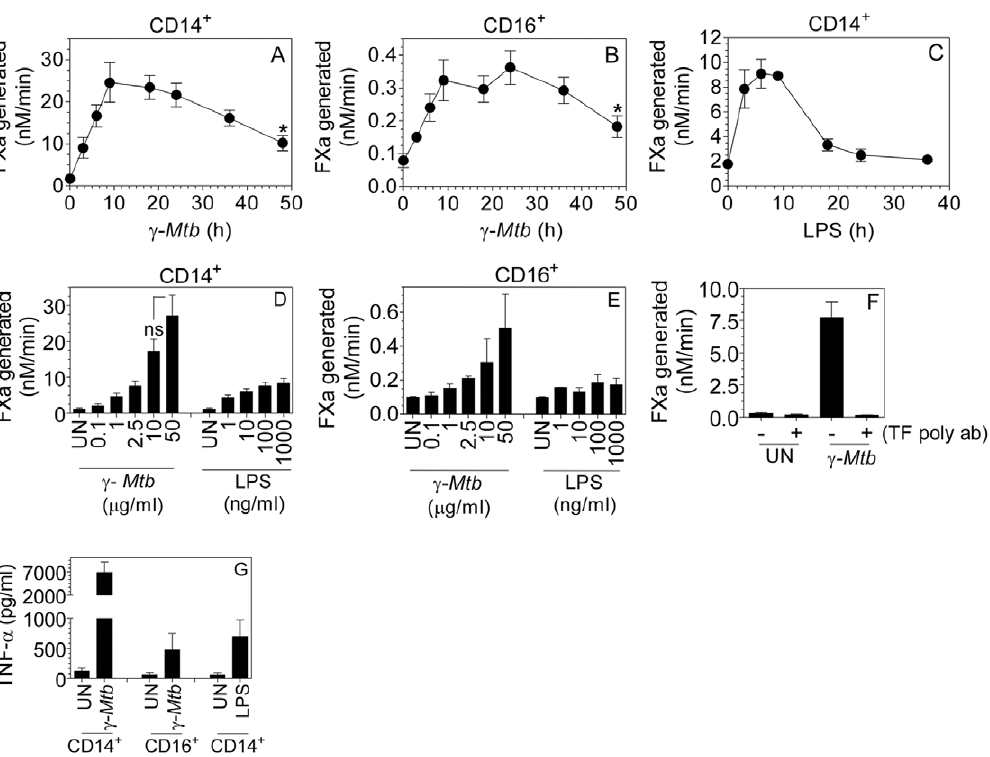
Figure 1. c -irradiated H37Rv Mtb ( c -Mtb ) induces TF expression in macrophages. MDMs were stimulated for varying time periods with c - Mtb H37Rv (10 m g/ml, A and B ) or LPS (100 ng/ml, C ) in complete RPMI medium. TF activity in the cell lysates was measured in factor X activation assay. Please note differences in Y-axis scale in three panels. CD14 + ( D ) CD16 + ( E ) MDMs were treated with varying doses of c - Mtb H37Rv or LPS for 9 h or 6 h, respectively, and TF activity in the cell lysates was determined in factor X activation assay. ( F ) TF activity in the cell lysates of CD14 + treated with c - Mtb for 9 h was measured in the presence or absence of anti-TF polyclonal antibodies (10 m g/ml) ( G ) Cell supernatants of MDMs treated with c - Mtb (10 m g/ml) for 9 h or LPS (100 ng/ml) for 6 h were used to measure TNF- a using ELISA. * denotes significant difference from untreated control for all time points in both CD14 + and CD16 + (P , 0.05). Data are mean 6 SEM (n=3–6).